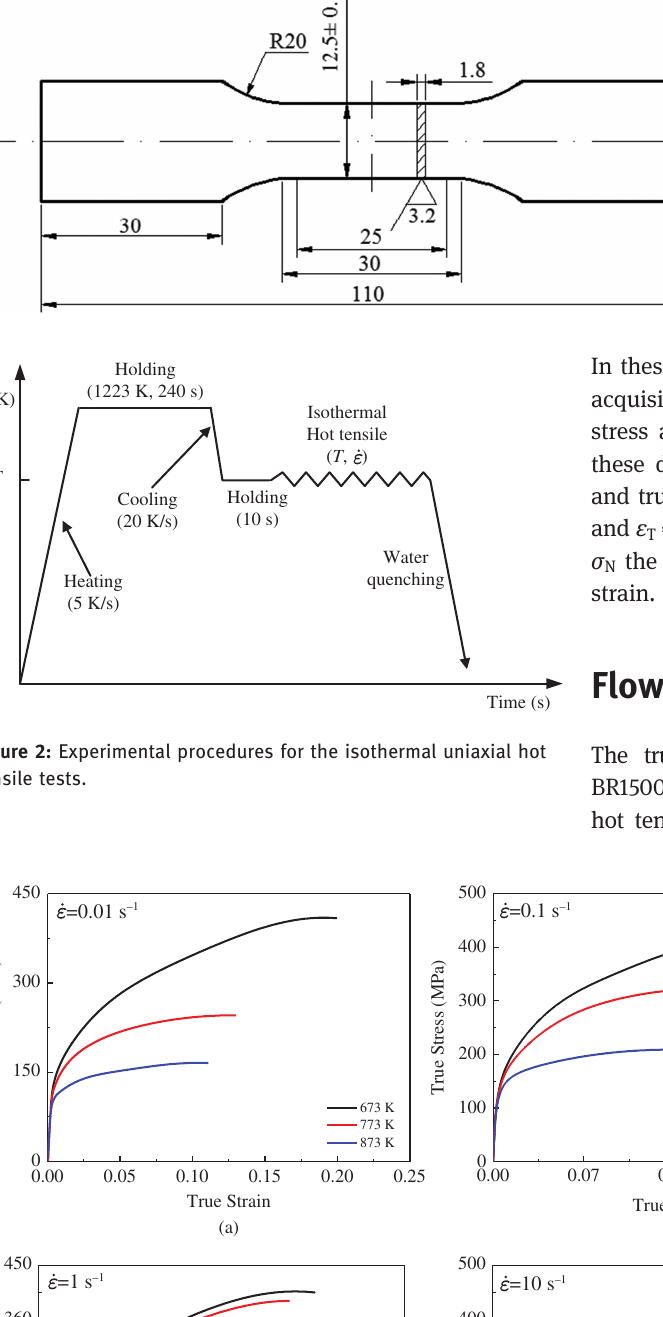
Figure 1: Specimen for isothermal uniax- ial hot tensile tests (unit: mm).